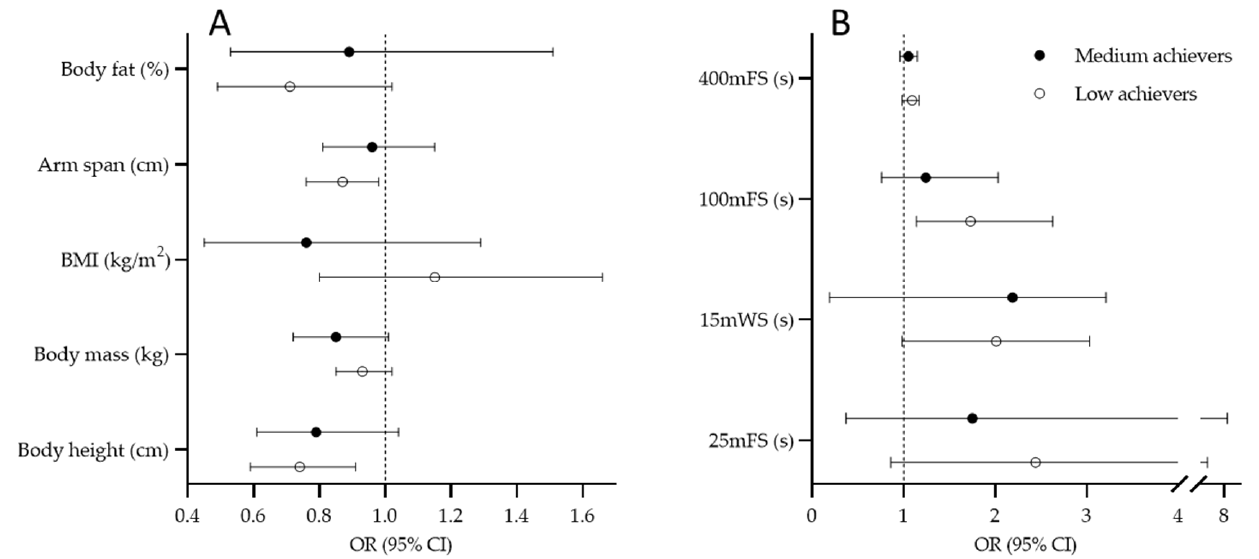
Figure 3. Results of the multinomial logistic regression for criterion “success at senior level” with high-achievement group as reference value for anthropometric predictors ( A ) and swimming predictors; ( B ) center players (BMI, body mass index; 25 mFS, 25 m freestyle swimming; 15 mWS, 15 m water polo swimming; 100 mFS, 100 m freestyle swimming; 400 mFS, 400 m freestyle swimming).